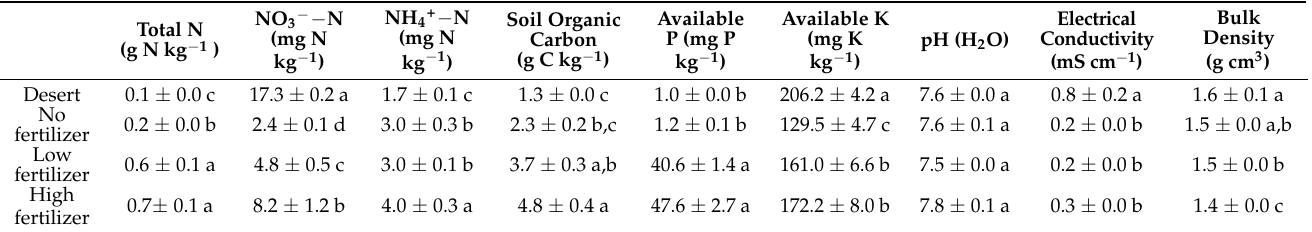
Table 1. Properties of 0–20 cm soil in each treatment before sowing in 2019. Values are the means ± 1 standard error, n =